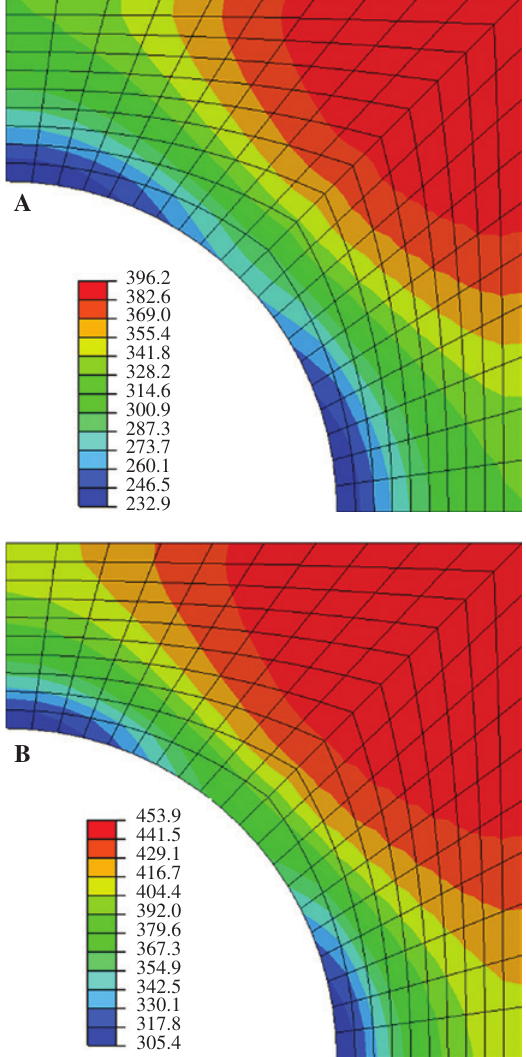
Figure 3: Axial stress distribution of the Ti matrix during the consol- idation process in (A) air and (B) nitrogen environment (unit: